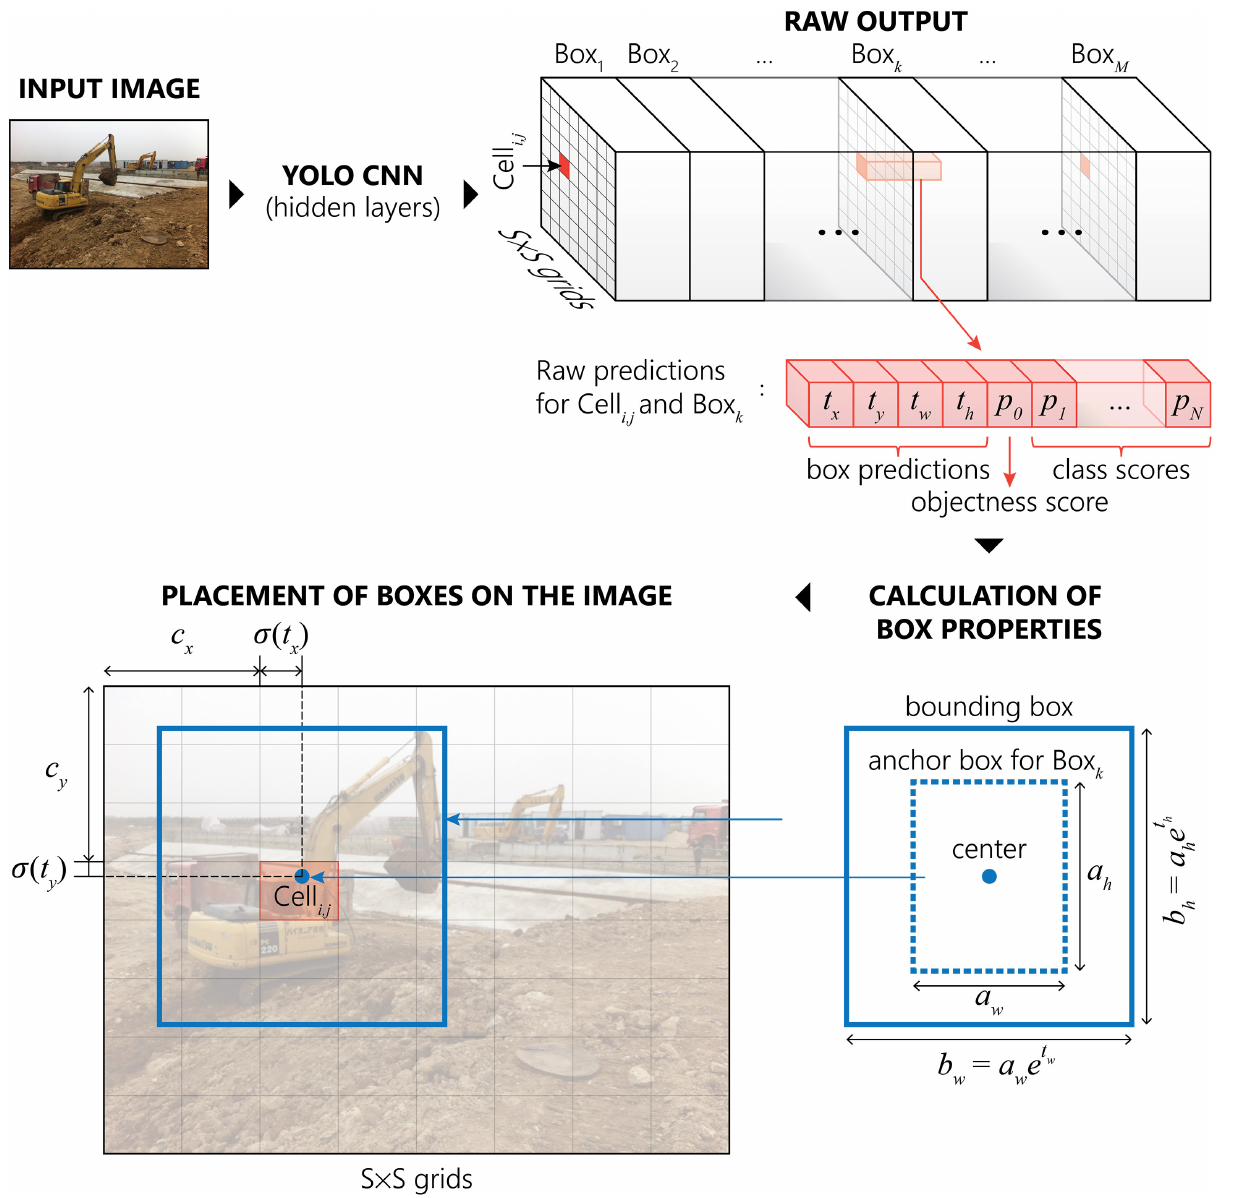
FIGURE 1 | Schematic diagram of the YOLO